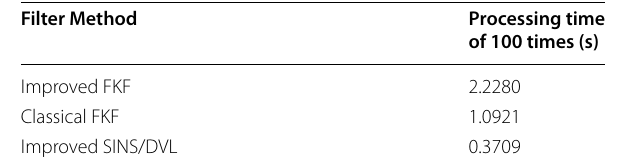
Table 3 The processing time comparison of different